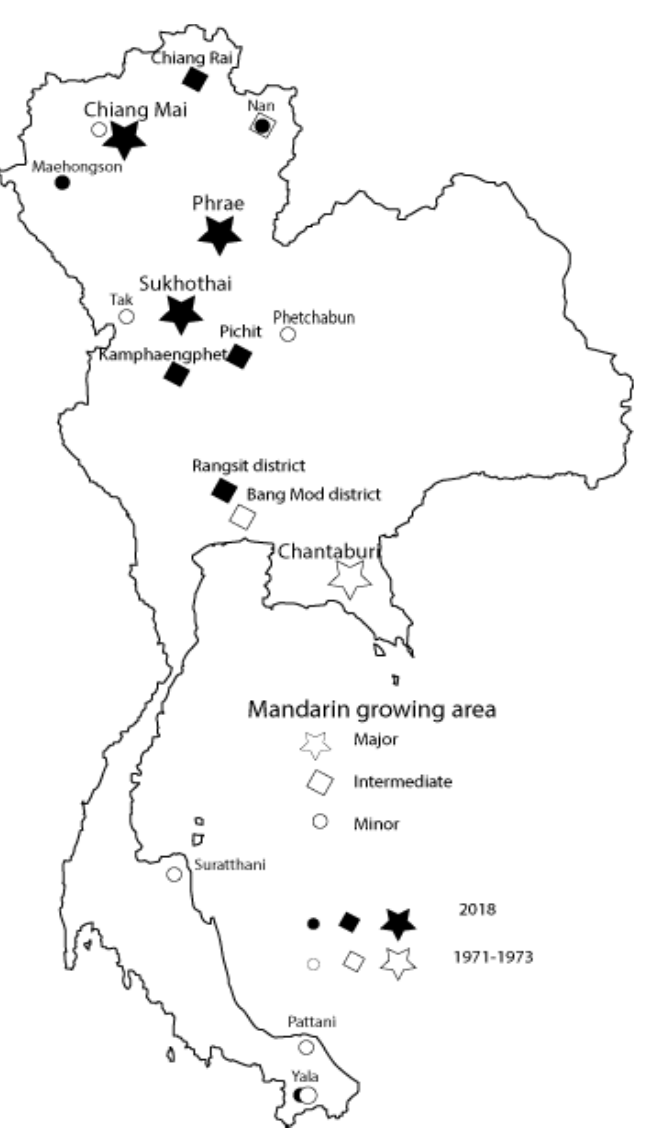
Figure 1 . Map of major mandarin growing areas in 1971–1973 and 2018. Source map: ChristianBier, CC BY-SA 3.0. Source data: Schwarz, Knorr, and Prommintara 1973; Office of Agricultural Economics